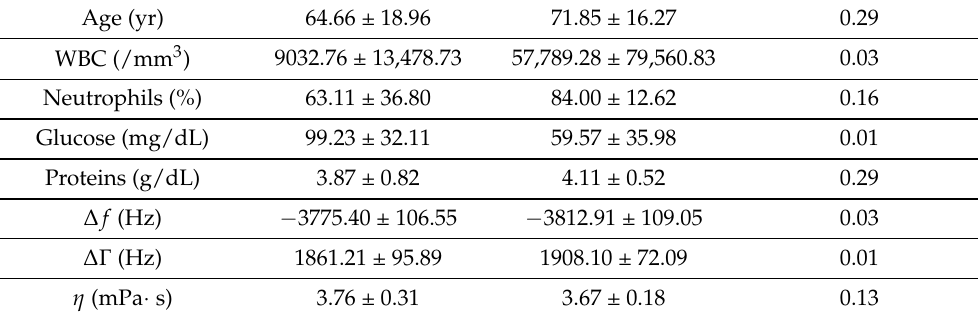
Table 4. Comparison between mean values for SF contained in tubes with lithium heparin.